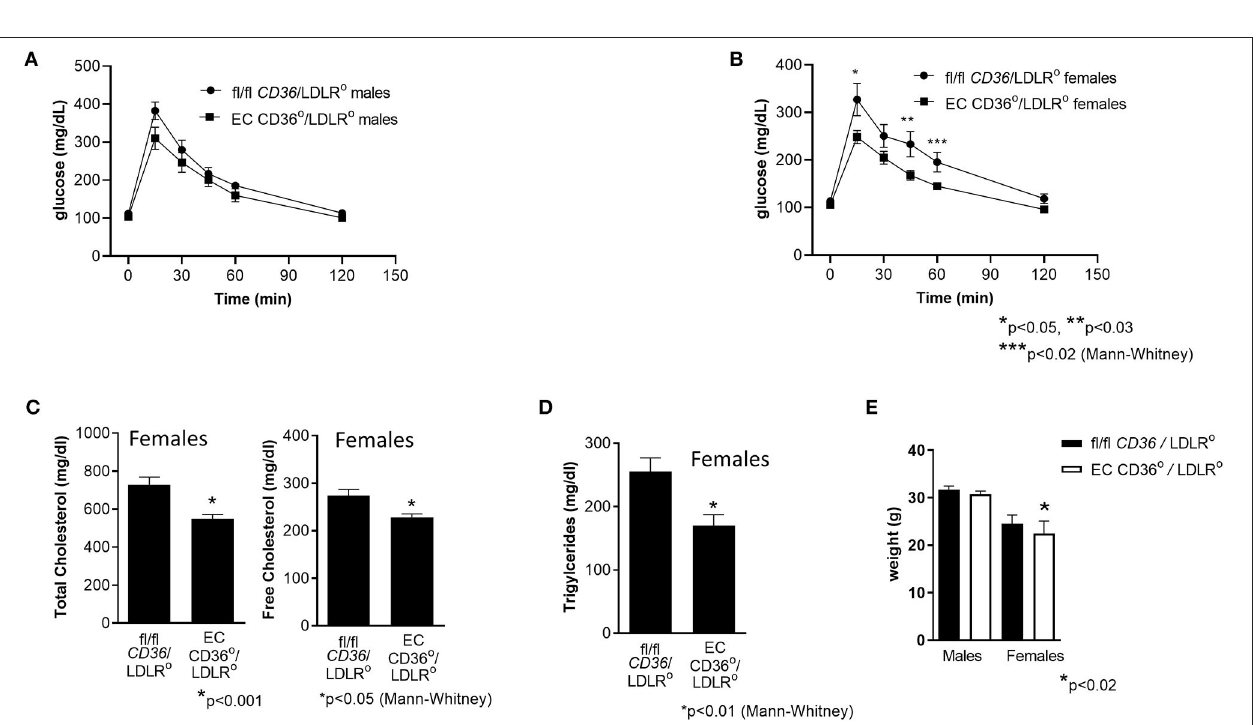
FIGURE 7 | Glucose tolerance testing of EC CD36 ◦ /LDLR ◦ and fl/fl CD36 /LDLR ◦ mice after 10 weeks of high-fat high-cholesterol diet feeding. (A) Male EC CD36 ◦ /LDLR ◦ mice showed a significant difference at the 0 time point. AUC was not different (fl/fl CD36 /LDLR ◦ , n = 4; EC CD36 ◦ /LDLR ◦ , n = 7). (B) Female EC CD36 ◦ /LDLR ◦ mice showed significant differences at all time points. AUC was significantly different (fl/fl CD36 /LDLR ◦ : 30,817 ± 1,142; EC CD36 ◦ /LDLR ◦ : 19,331 ± 1,161, p < 0.0001) (fl/fl CD36 /LDLR ◦ , n = 9; EC CD36 ◦ /LDLR ◦ , n = 5).